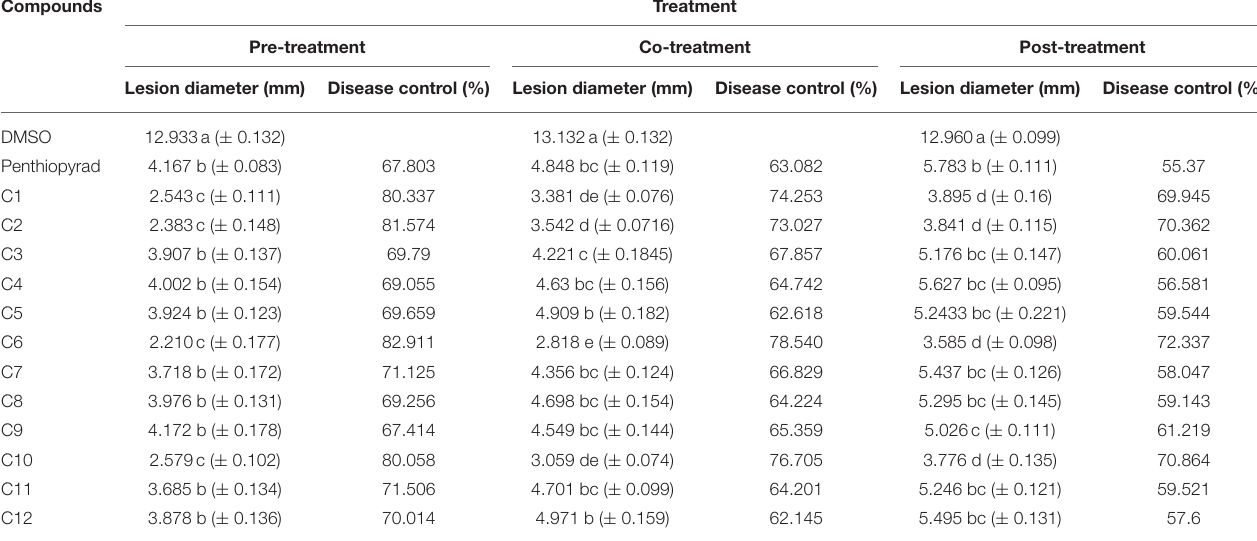
TABLE 3 | Comparison of lesion diameter and % disease (EB) control after treatment with SDHIs on potato leafs under Greenhouse conditions. Compounds Treatment Pre-treatment Co-treatment Post-treatment